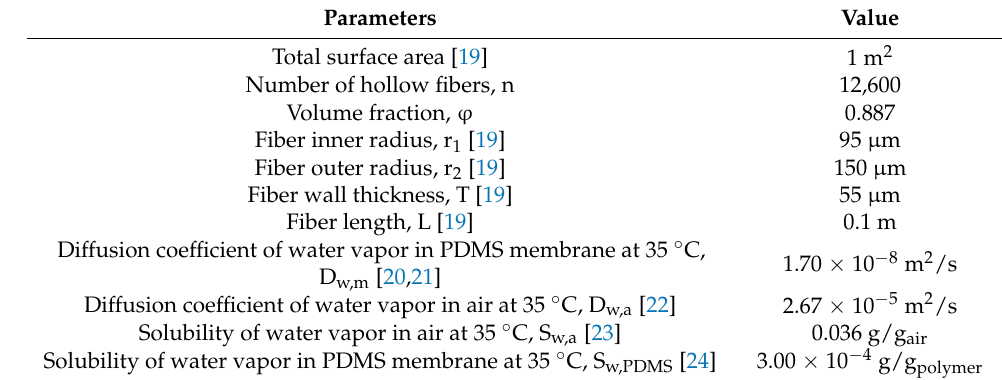
Table 1. Geometric information of the hollow fiber membrane module and single hollow fiber and physical properties of PDMS membrane